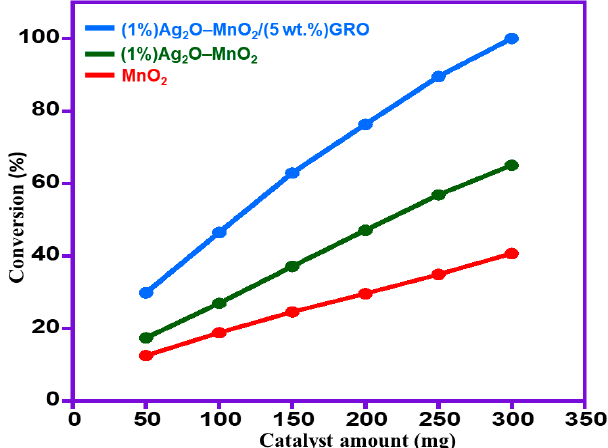
Figure 10. Impact of catalyst quantity on the oxidation of BnOH using various catalysts.